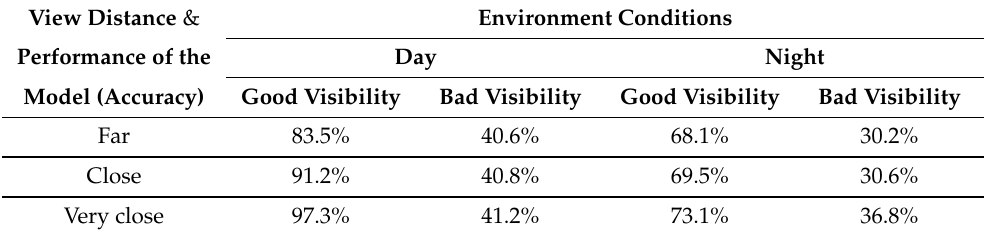
Table 2. Results of the traffic sign detection model’s accuracy. View Distance